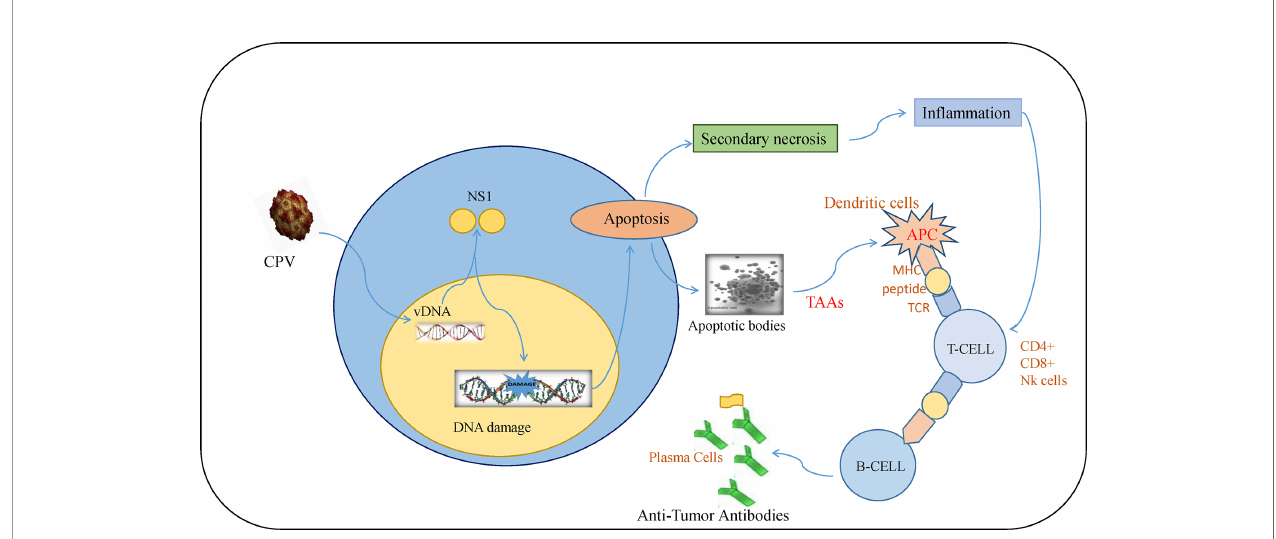
FIGURE 5 | Immune response induced by CPV2.NS1 in cancer cells: CPV2.NS1 induces a potent anti-tumor immune response, thereby generating antibodies against tumor-associated antigens. Once CPV2.NS1 induces apoptosis or causes direct cell lysis, apoptotic bodies, and TAAs are released which are presented to MHC-I by antigen-presenting cells (APC). It also activates tumor-speci fi c CTLs (CD8+ cells and Nk cells) which are involved in killing cancer cells. T-helper cells are also activated which help in maintaining CTL numbers and present the antigens to B-cells leading to the production of anti-tumor